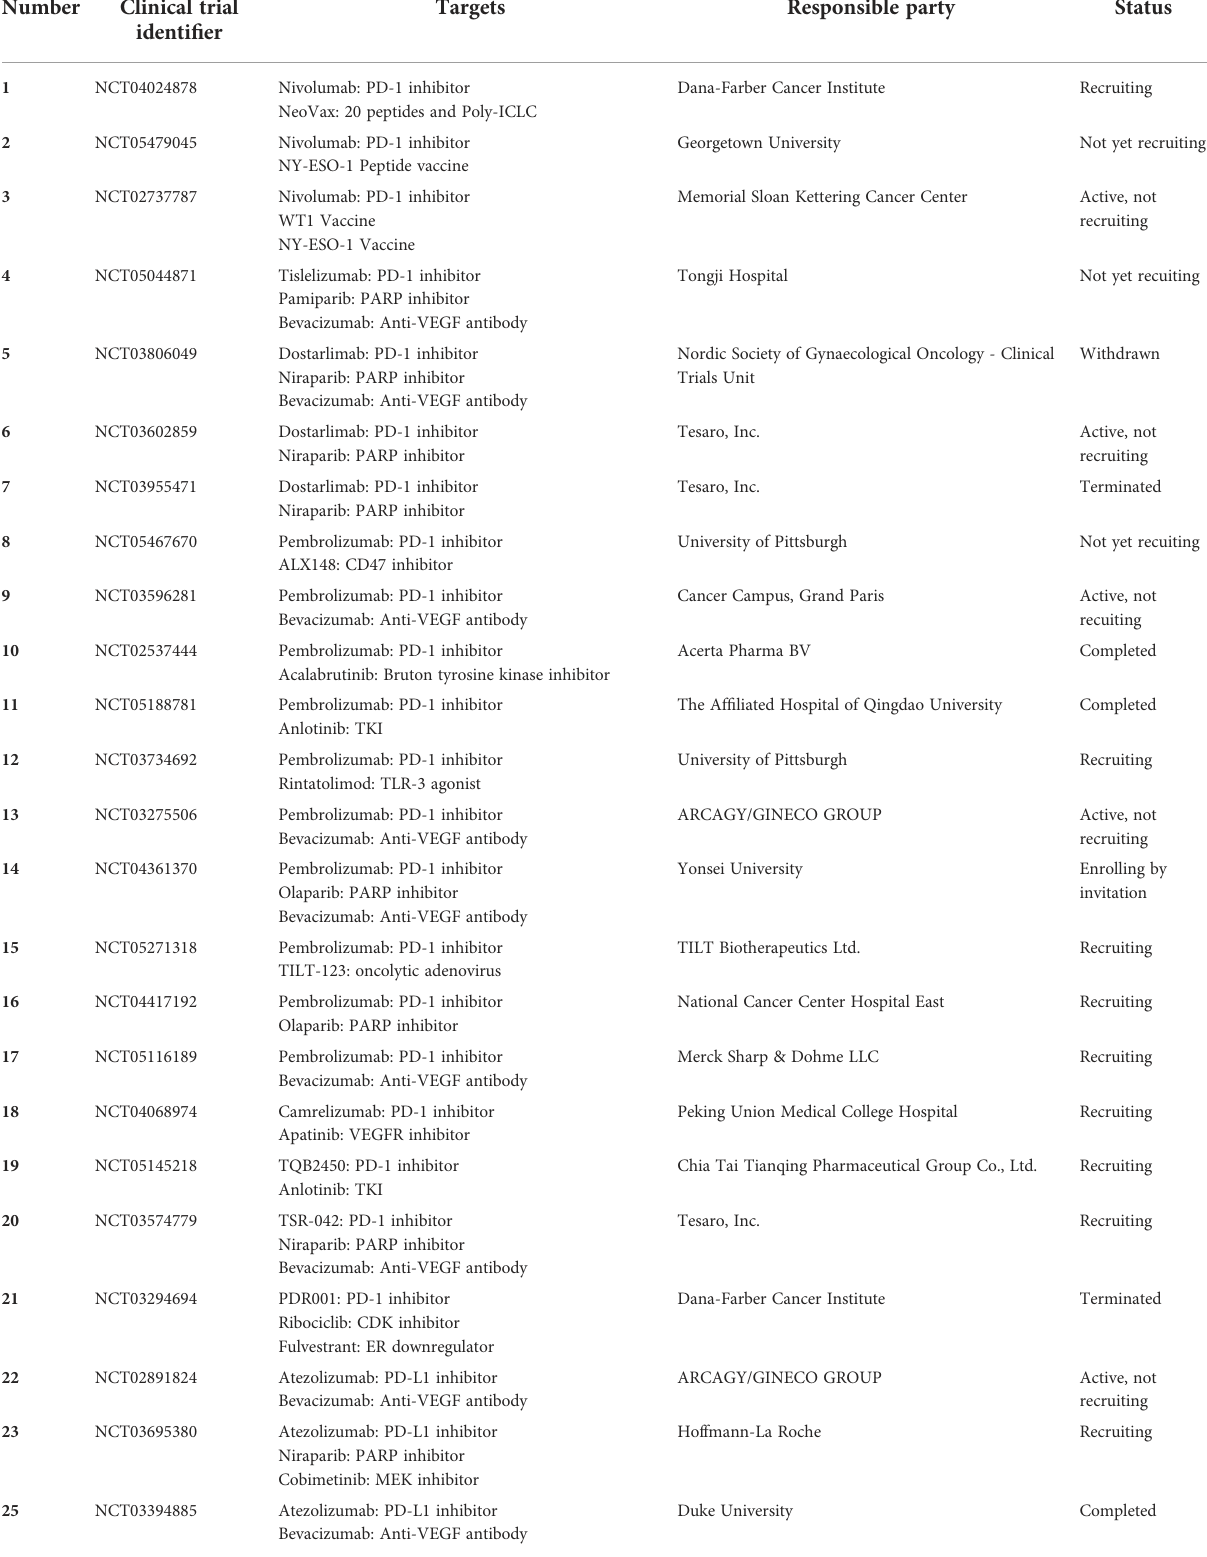
TABLE 1 Clinical trials of multi-immunotherapy in ovarian